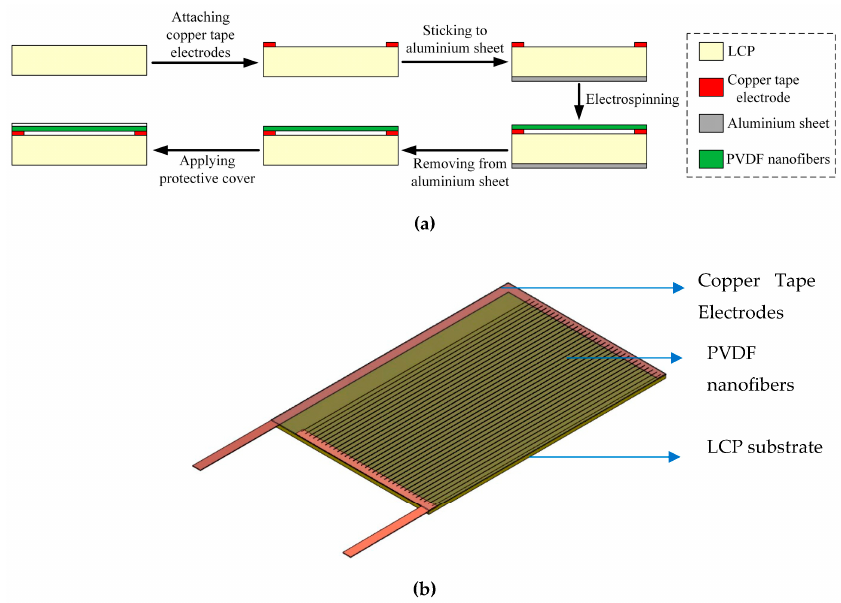
Figure 2. Development of the PVDF nanofiber sensor. ( a ) Schematic of the fabrication steps of the sensor; ( b ) Schematic of the final developed sensor.